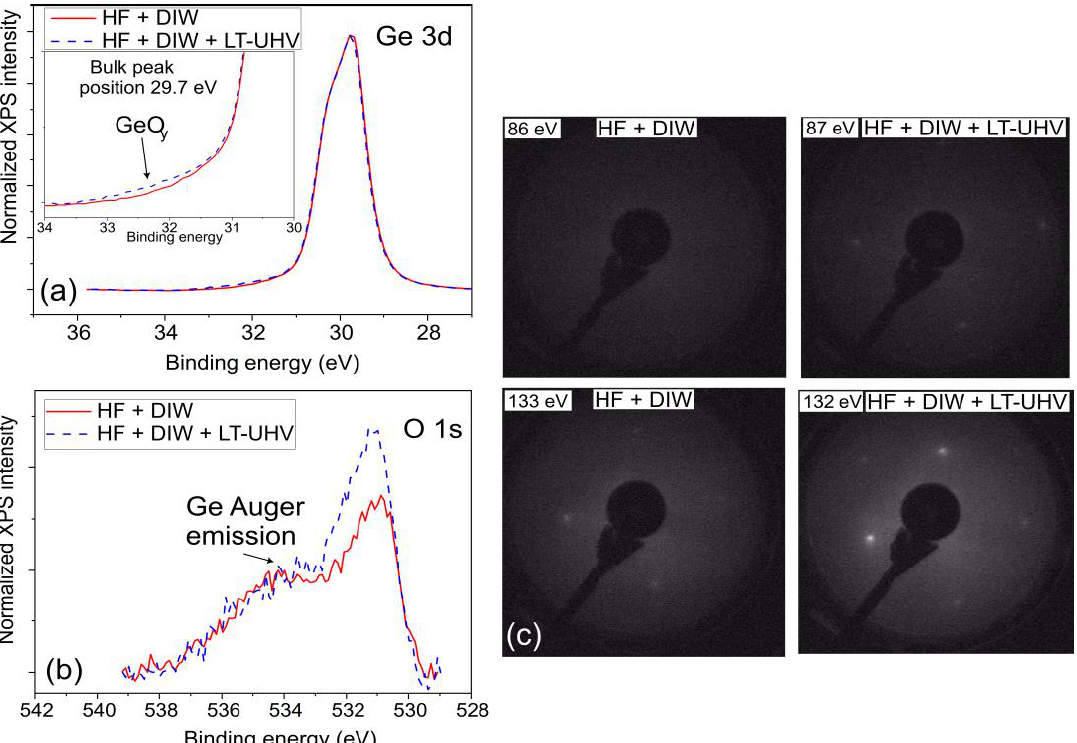
Figure 3. ( a ) Ge 3d and ( b ) O 1s XPS spectra for HF + DIW-cleaned samples with and without the LT-UHV treatment. ( c ) LEED patterns for same samples.